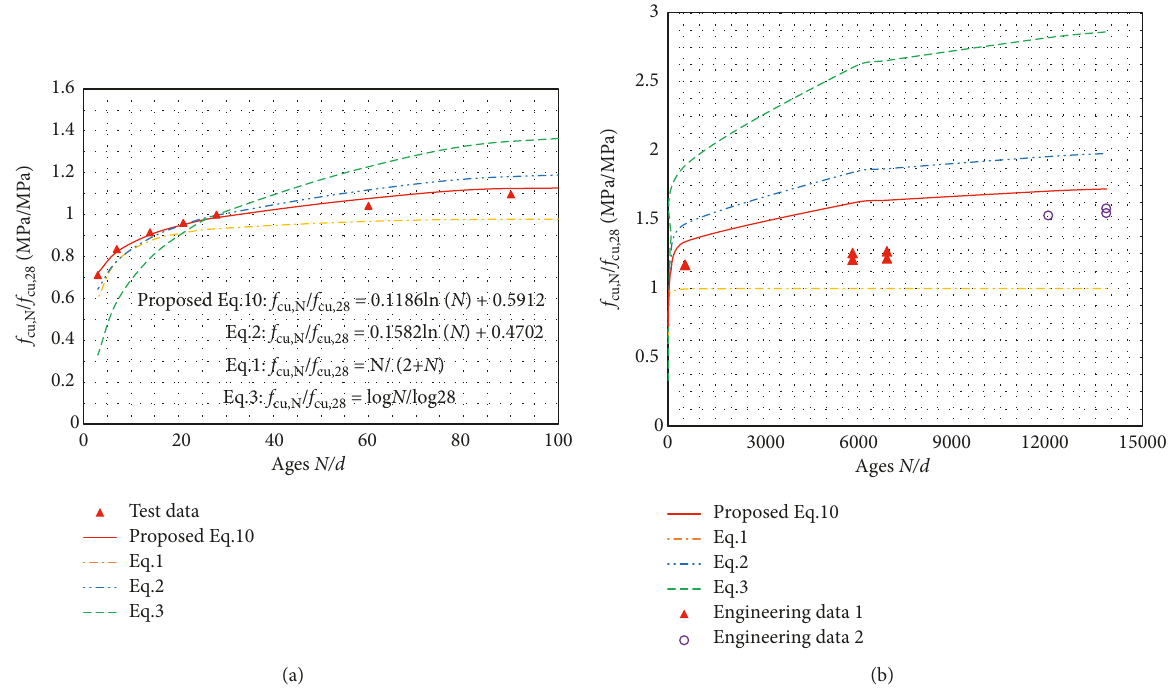
Figure 15: Relationship between relative compressive strength versus age. (a) Experimental data. (b) Engineering data.